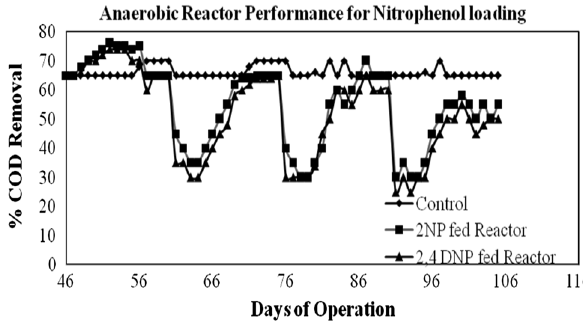
Fig. 1 COD removal efficiencies of anaerobic set of three reactors during the start-up phase